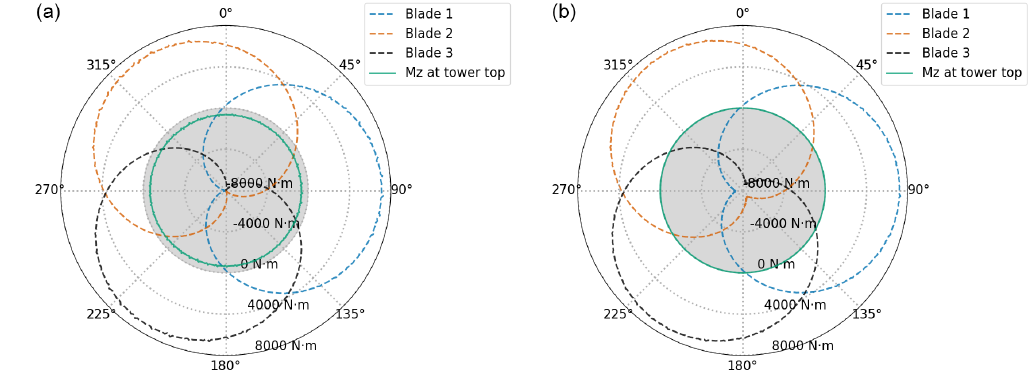
Figure 6. Tower-top total yaw moment (solid green), contribution of each blade (blade 1 in dashed blue, blade 2 in dashed orange and blade 3 in dashed black) and corresponding combined contribution of the three blades with respect to azimuth (20ms − 1 uniform wind speed), with (a) and without (b) tilt.